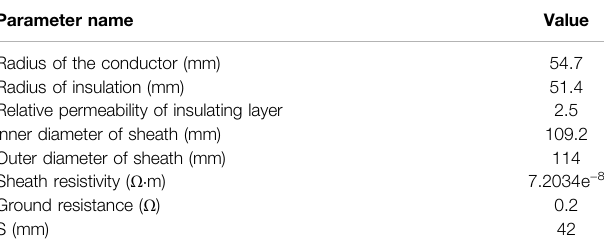
TABLE 1 | Material parameters of typical single-core cable